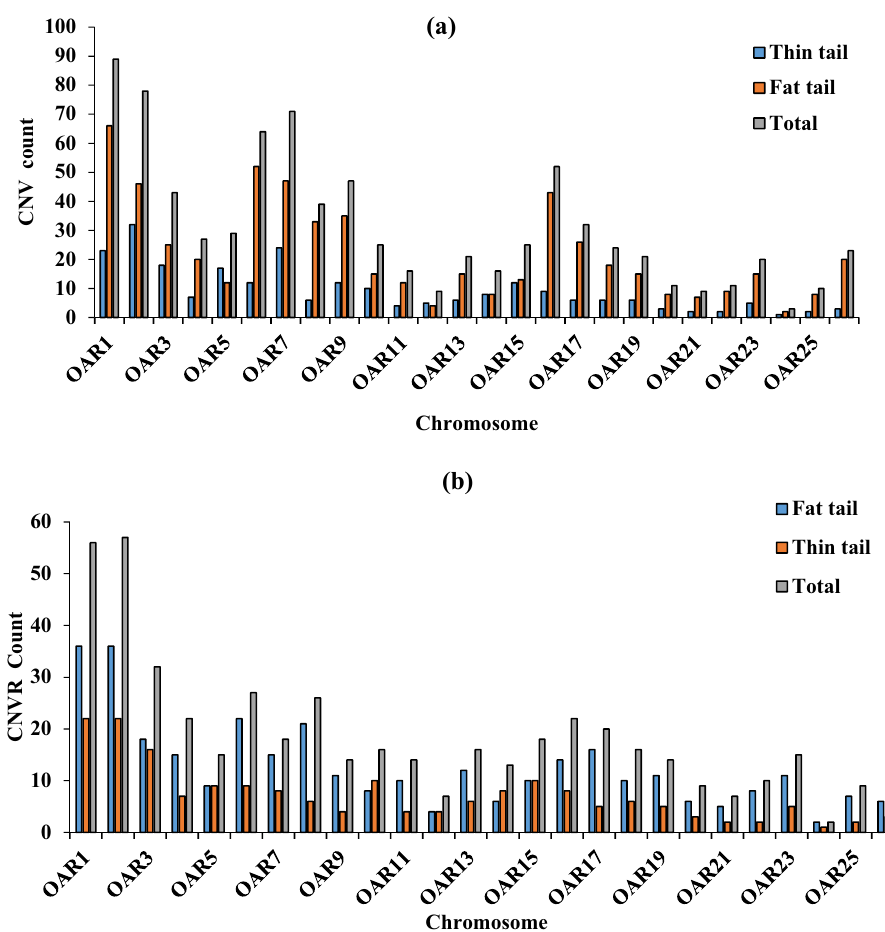
Figure 3. Distribution of the CNVs ( a ) and CNVRs ( b ) number on the 26 autosomal sheep chromosomes.